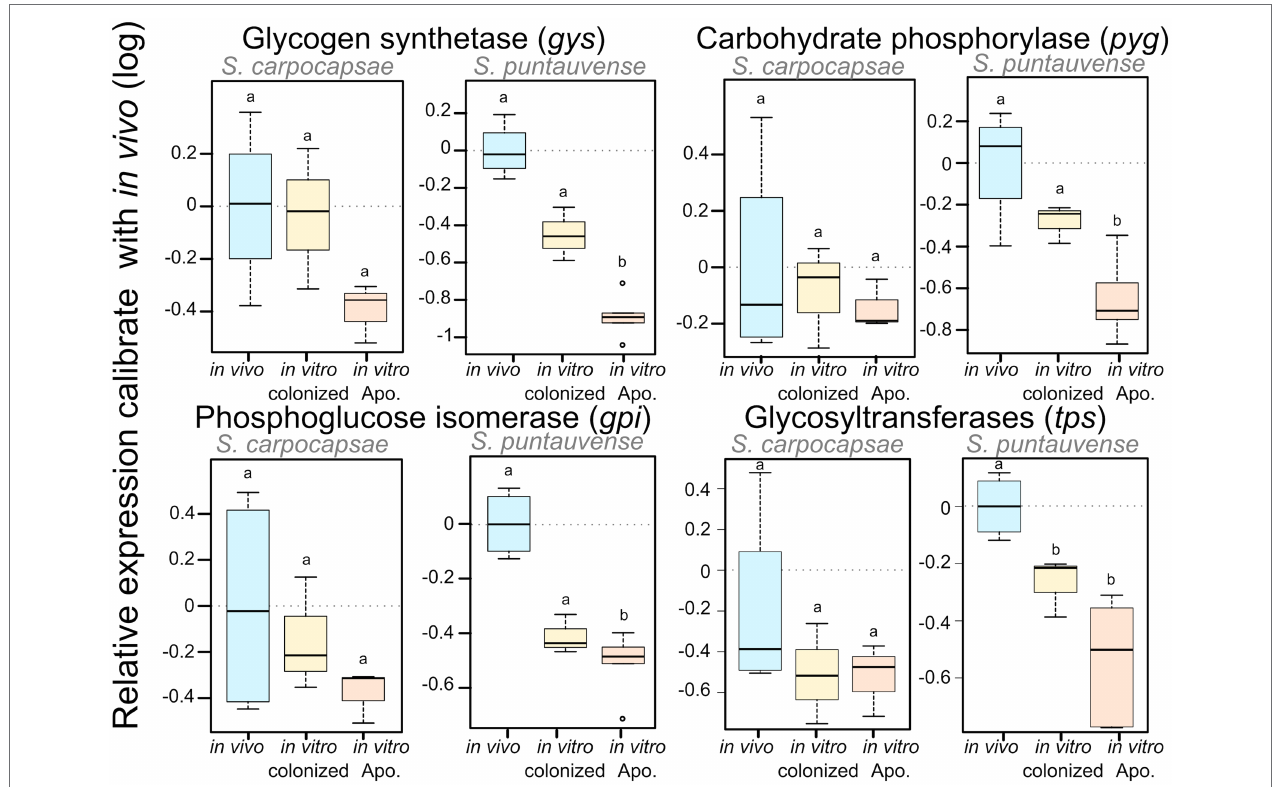
FIGURE 4 | Boxplot of the relative expression of three transcripts involved in glycogen metabolism ( gys , pyg , and gpi ) using qRT-PCR. The relative expression was calculated using a modified Pfaffl model normalized with the two-housekeeping actin and MCM genes and calibrated with the value detected for the in vivo reared nematodes’ RNA. Boxplot shows the log of the calculated relative expression. Differential expression was tested by either one way ANOVA associated with post-hoc Tukey’s HSD or the non-parametric Kruskal-wallis rank sum associated with multiple pairwise comparisons using the Dunn’s test according to applicable condition. Bars labeled with the same letter are not significantly different from each other. Details of statistical test are shown in Supplementary Table S5